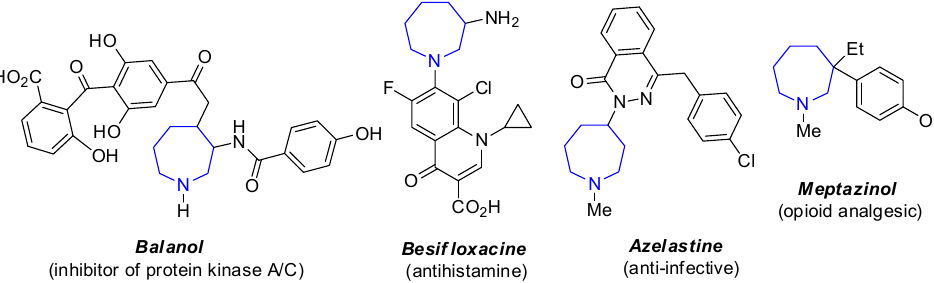
Figure 1. Bioactive molecules containing azepane rings.